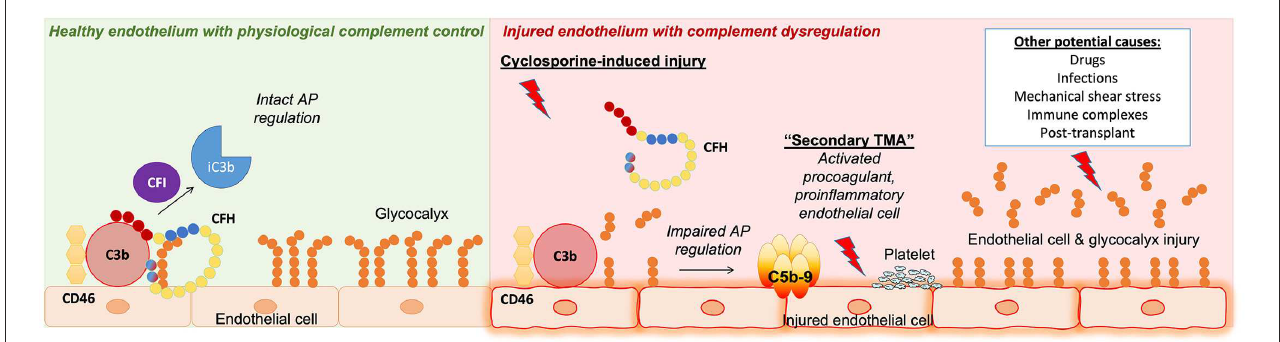
FIGURE7 Summary of key findings and concepts presented in our work. (Left) Healthy endothelium with physiological complement control where the regulation of the complement alternative pathway (AP) is intact. Complement factor H (CFH) acts as a cofactor with complement factor I (CFI) and membrane cofactor protein (CD46) to inactivate C3b on endothelial cell surfaces. (Right) Injured endothelium with complement dysfunction. Our work presented in this study identified a role for complement in cyclosporine-induced endothelial cell injury. We showed that endothelial cells exposed to cyclosporine had decreased glycocalyx density, leading to complement AP dysregulation via decreased CFH surface binding and cofactor activity. This mechanism of endothelial cell and glycocalyx injury leading to complement AP dysfunction could potentially be applicable to other forms of secondary thrombotic microangiopathy